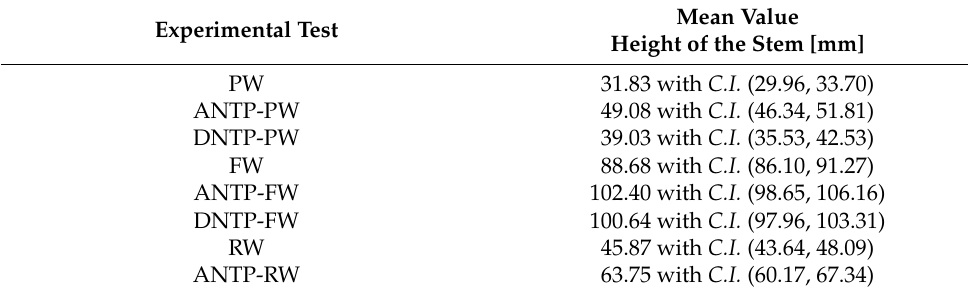
Table 3. Height of the stem according to the applied treatment after fifteen days.